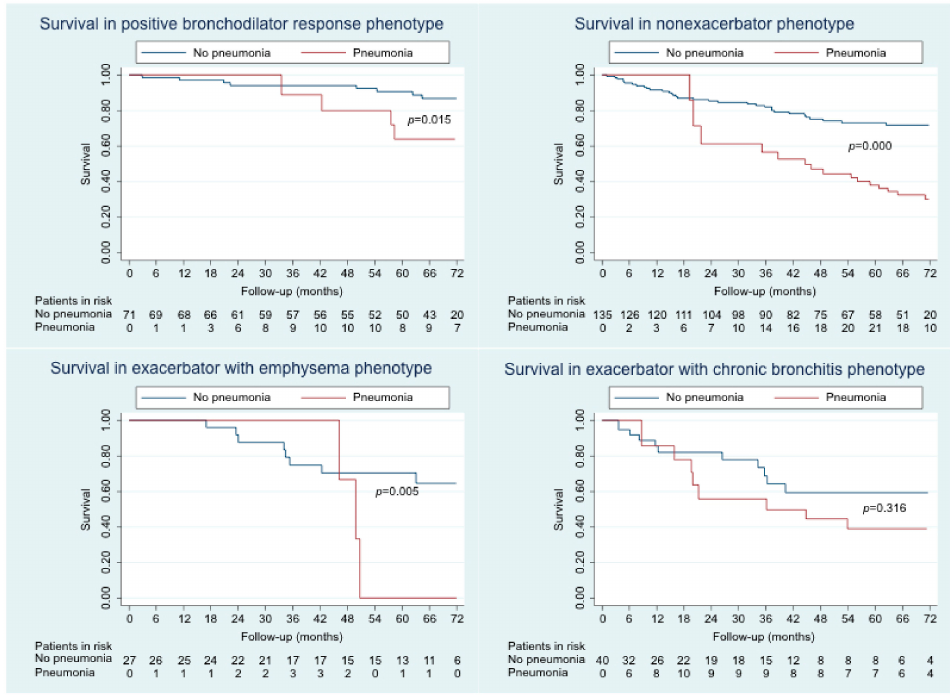
Figure 2. Survival according to the presence or absence of pneumonia in each COPD